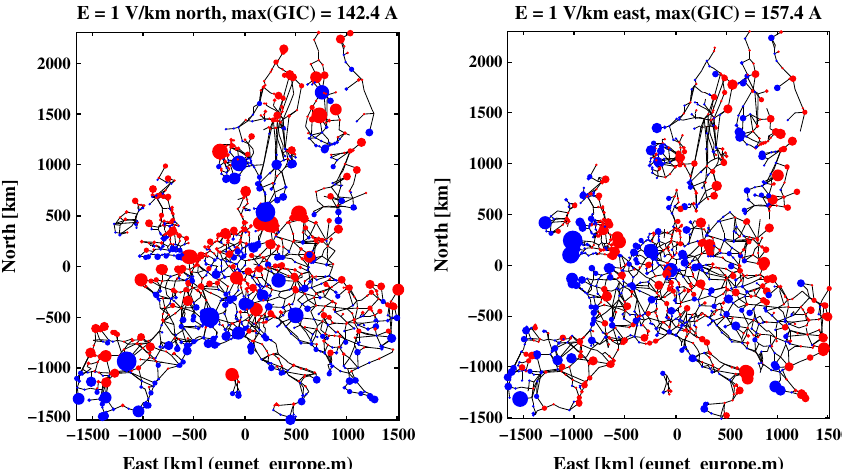
Fig. 1. GIC in the European high-voltage grid due to a spatially constant electric field of 1 V/km pointing to the North (left plot) or to the East (right plot). Red denotes currents flowing from the grid into the ground and blue denotes currents flowing from the ground into the grid.